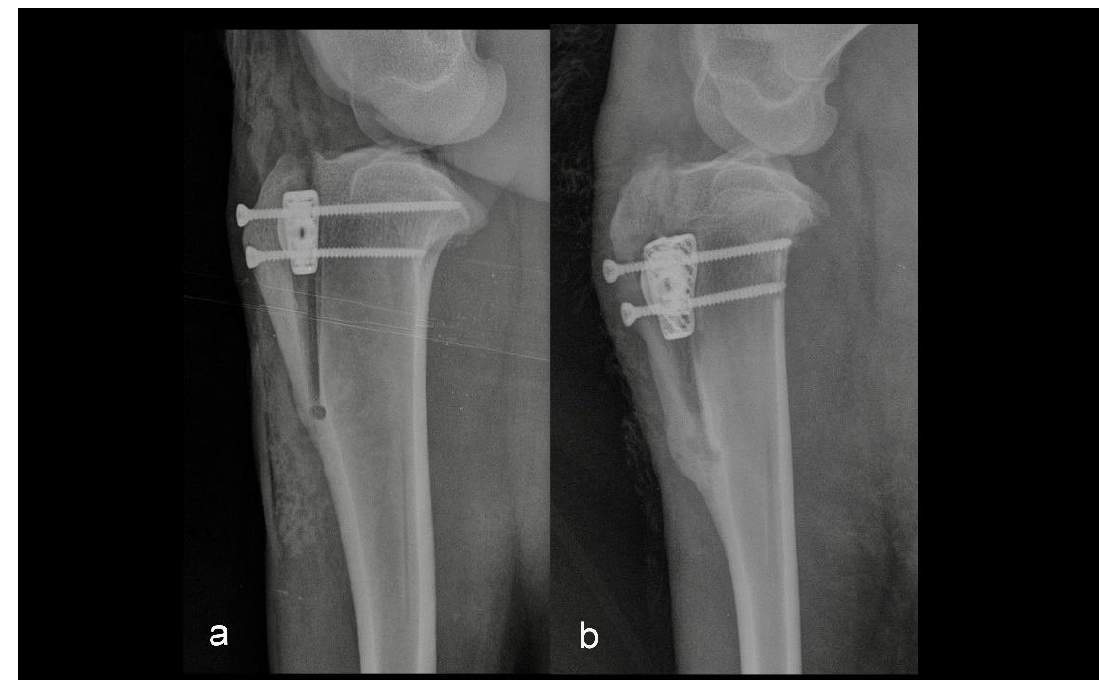
Figure 3. Mediolateral radiograph of the stifle in Group 2 immediately postoperatively ( a ) and at six months postoperatively ( b ). The osteotomy line was too close to the tibial tuberosity crest.